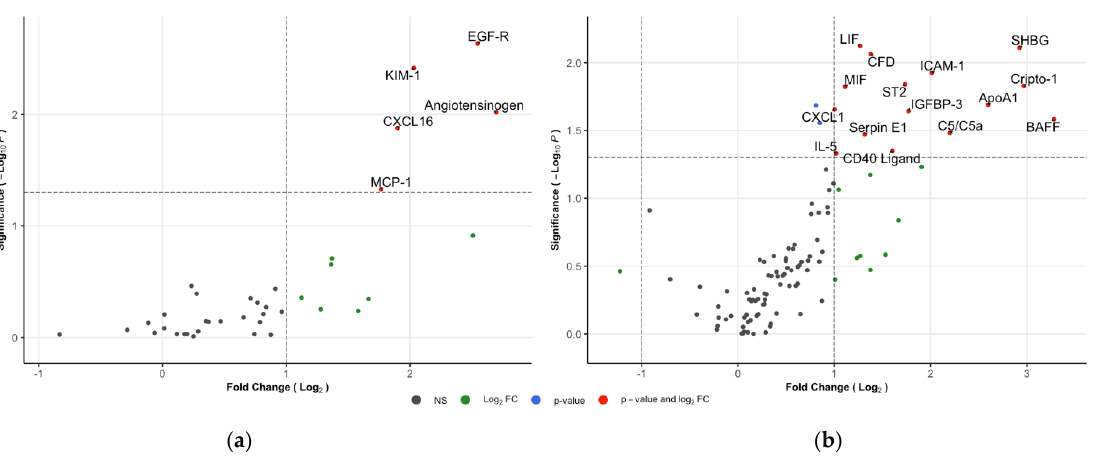
Figure 1. Exploratory data analysis representation: ( a ) Kit K: scores plot between principal component (PC) 1 and PC2 with the explained variance shown in brackets; ( b ) Kit C: scores plot between PC1 and PC2 with the explained variance shown in brackets.